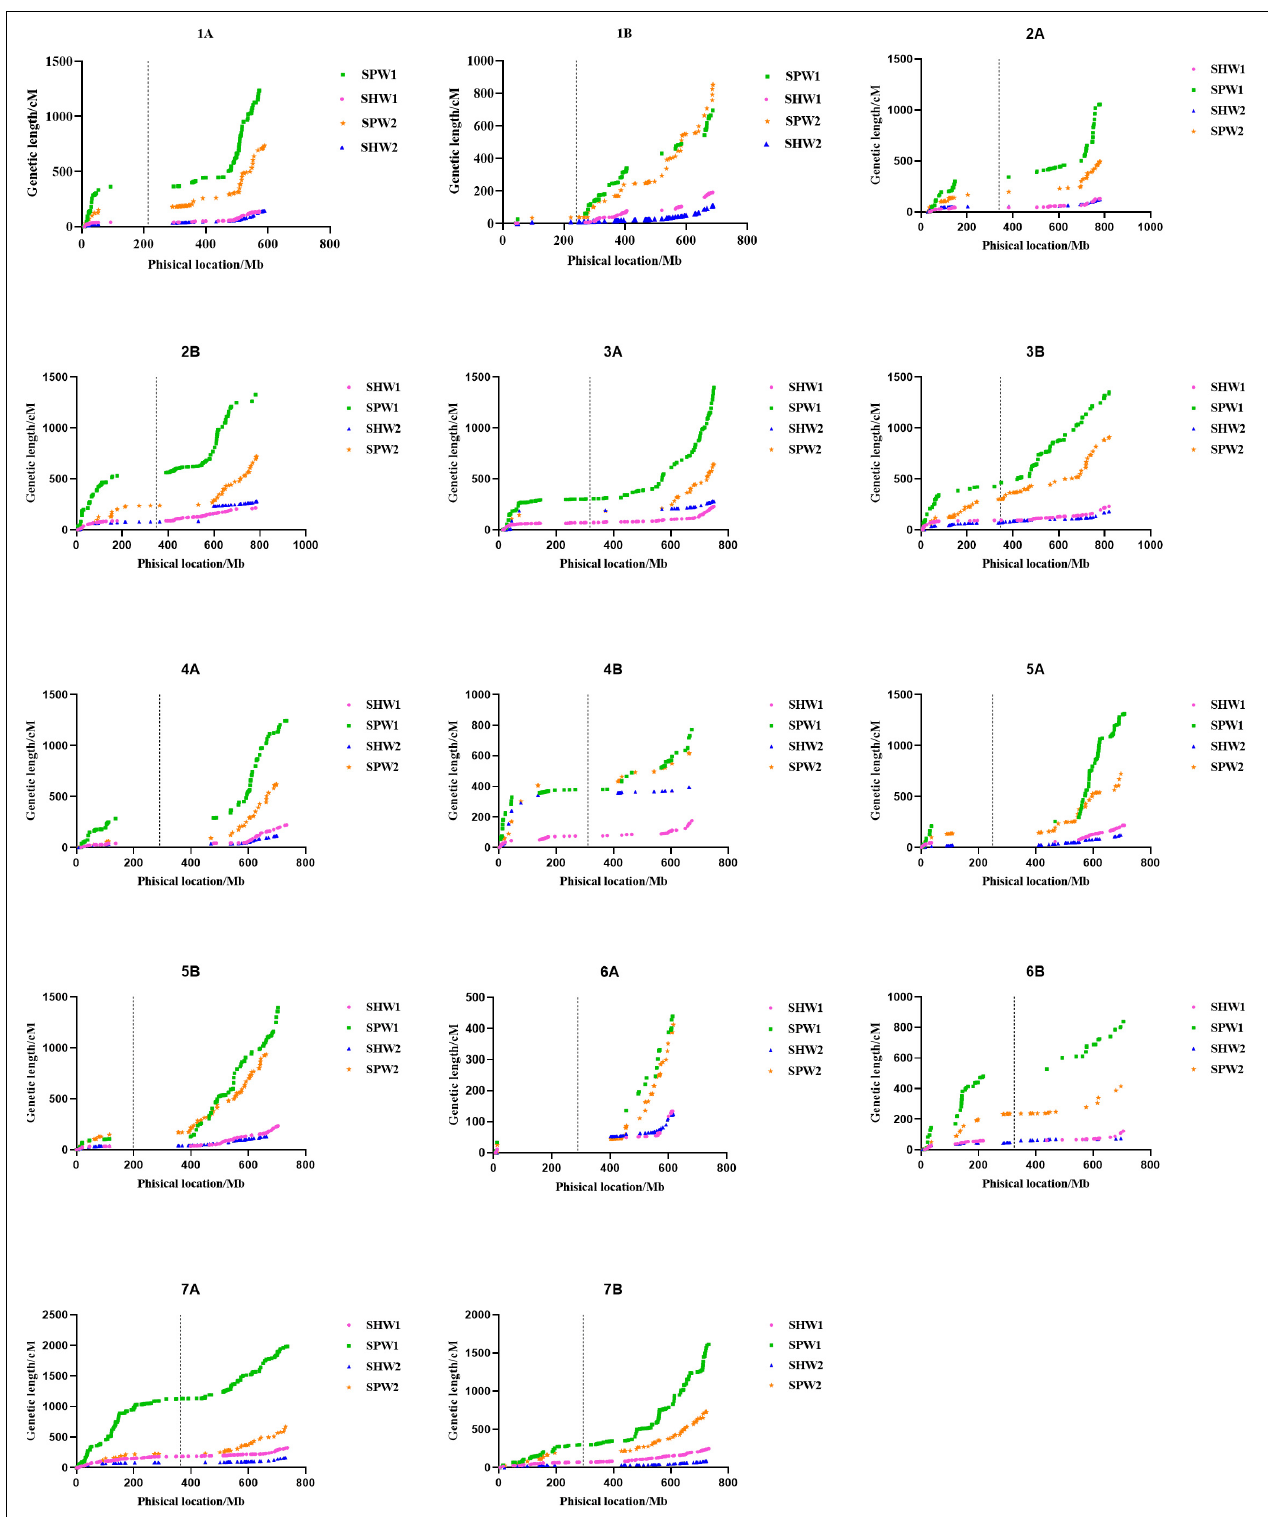
FIGURE 2 | Comparison of the genetic maps of each chromosome between pentaploid and hexaploid populations. The position of SNP markers was aligned with the IWGSC genome (version 1.0). Dotted lines indicate the physical location of the centromere on each chromosome.